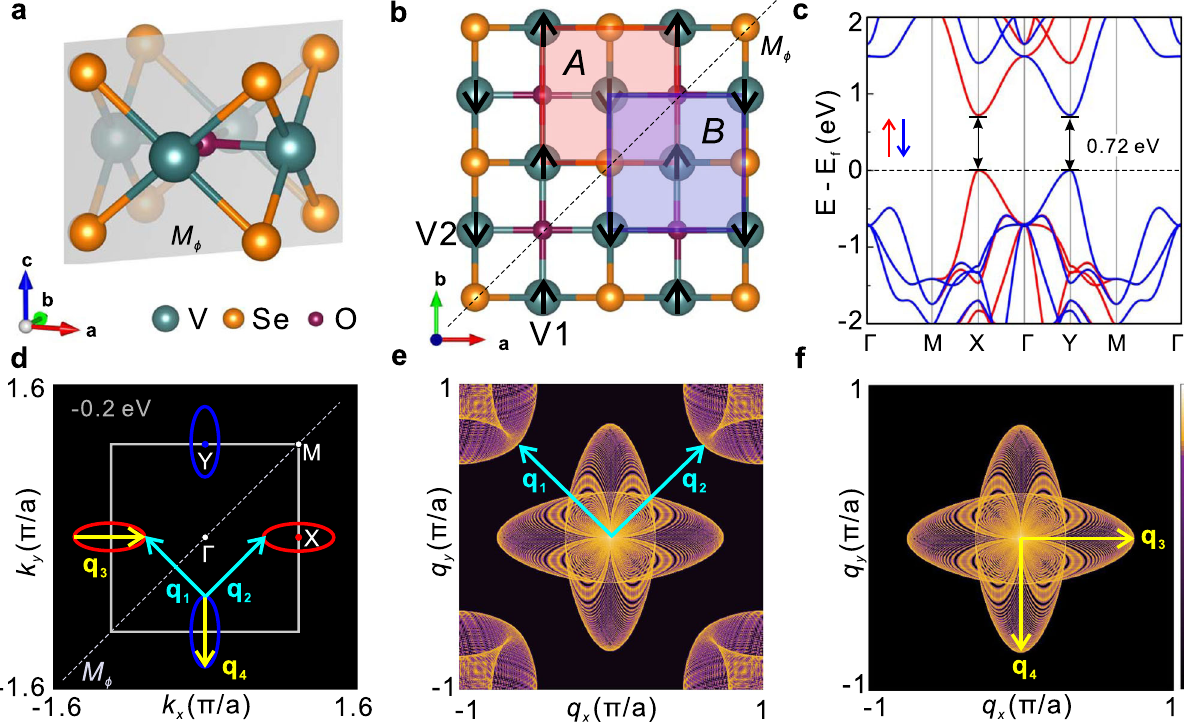
Fig. 2 C -paired SVL in monolayer V 2 Se 2 O. a Two sublattice A and B in monolayer V 2 Se 2 O is related by a diagonal mirror symmetry M ϕ . b 2D Néel antiferromagnetic (AFM) order with local magnetic moments located at V1 and V2 atoms with polarization labeled by black arrows. c Monolayer V 2 Se 2 O is a semiconductor with gap ~0.7 eV. Red (blue) color is for spin-up (down). d The energy contour taken at 0.2 eV below the valance band maximum with possible typical inter-valley and intra-valley scattering vectors q and q . e , f Calculated quasi-particle interference (QPI) patterns with and without 1 ; 2 3 ; 4 considering the spin fl ipping. Due to SVL and weak SOC, inter-valley scattering is strongly suppressed. The existence of AFM order and C -paired SVL can be easily veri fi ed by the absence of scattering patterns around the corner in QPI